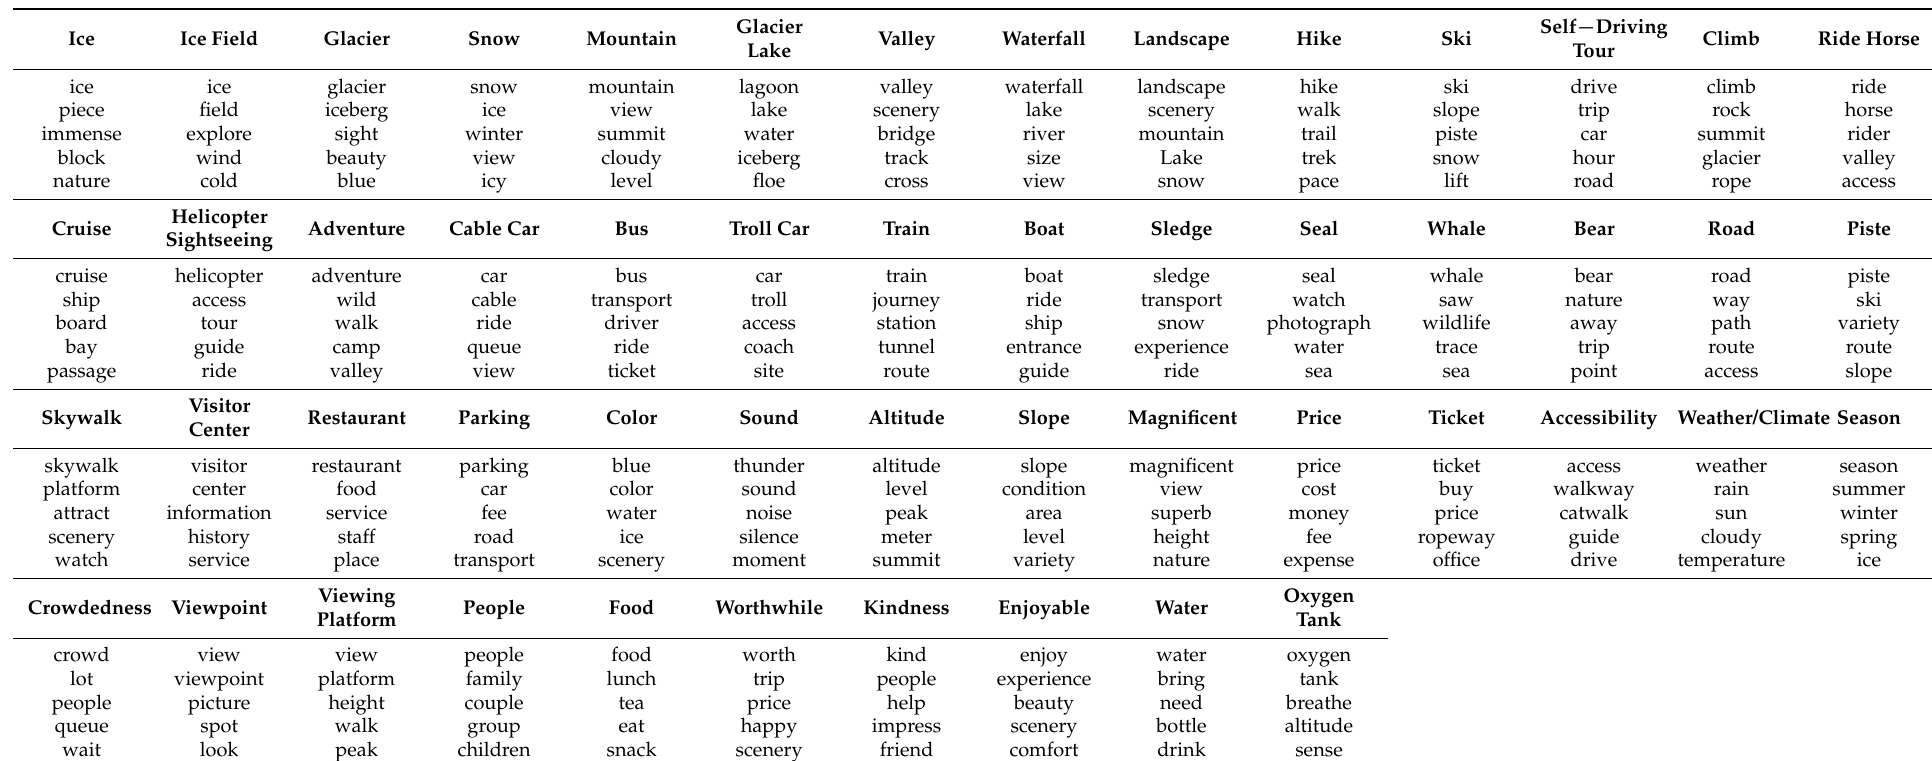
Table A2. Attribute dimensional glacier tourism destination image and its main topic